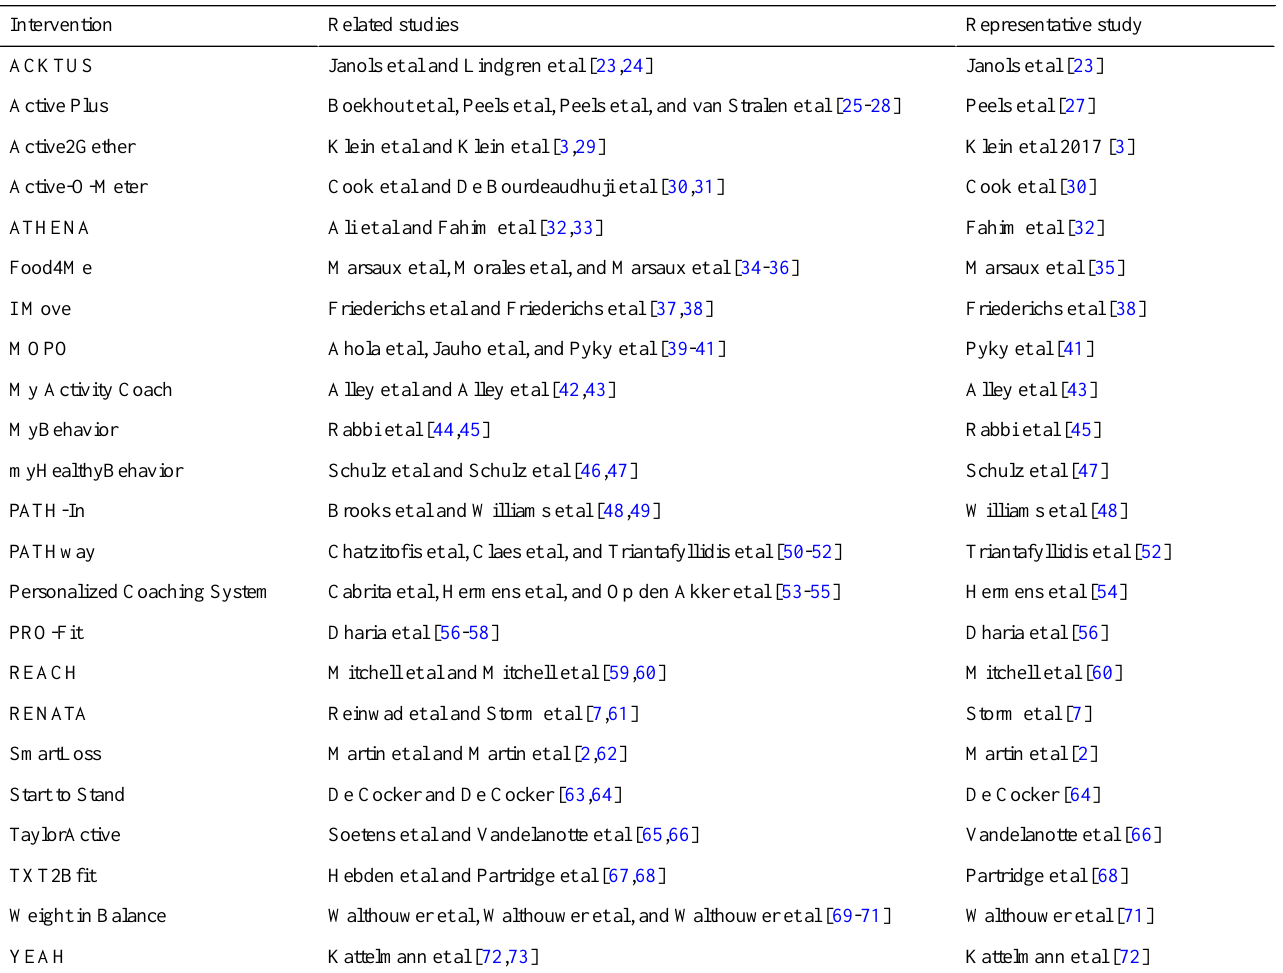
Table 1. Studies grouped by the intervention developed or investigated.